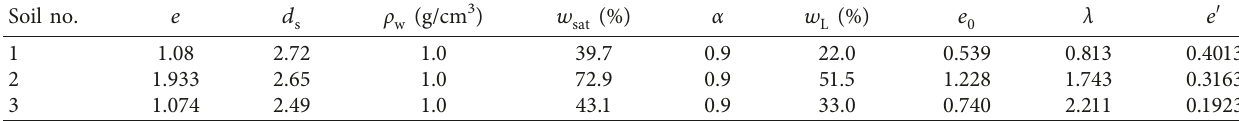
Table 6: The parameter λ and equivalent void ratio.